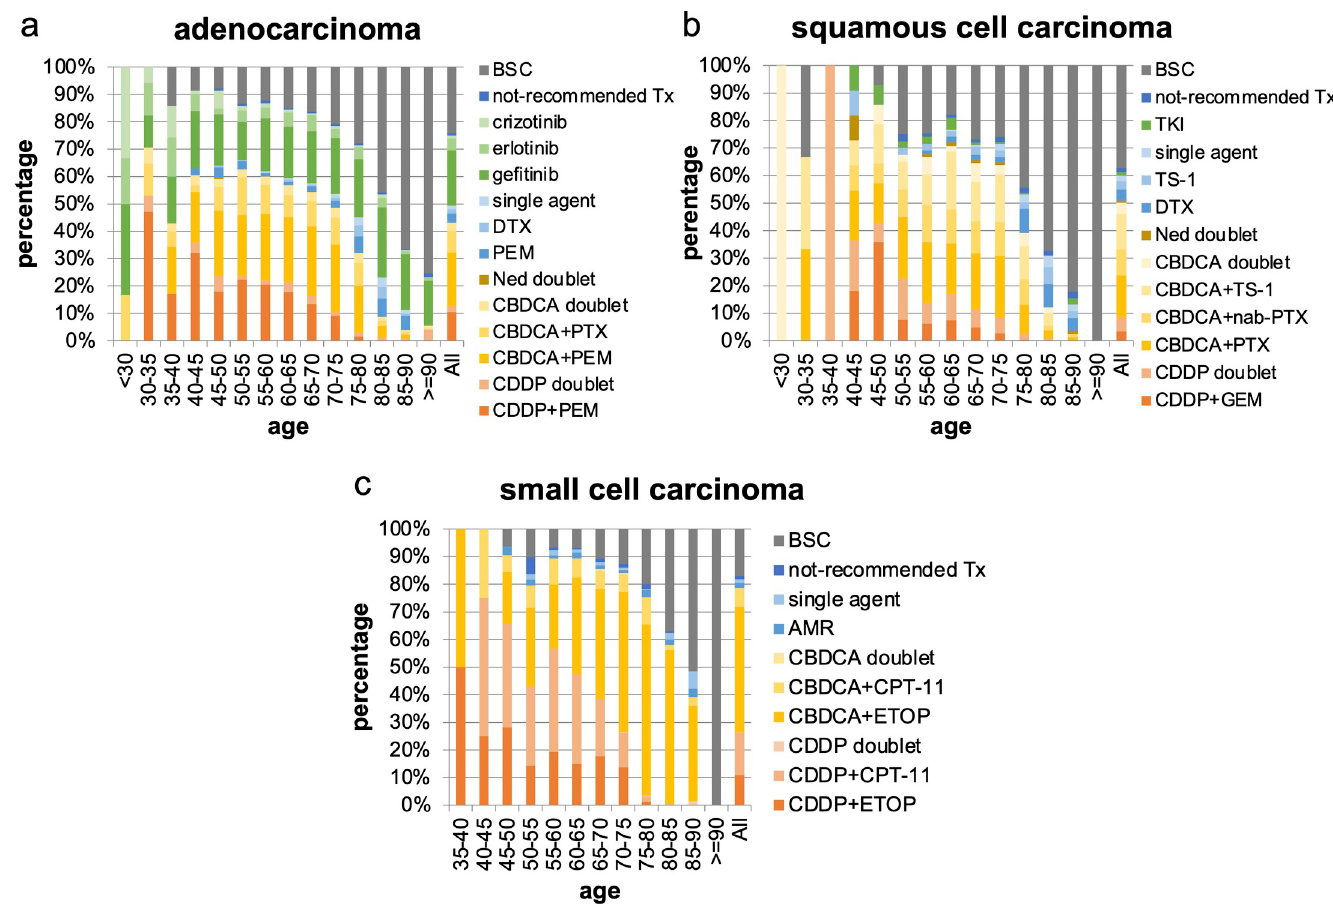
Fig 4. First-line treatment regimens by histology. (a) adenocarcinoma, (b) squamous cell carcinoma, and (c) small cell carcinoma. CDDP, cisplatin; PEM, pemetrexed; CBDCA, carboplatin; PTX, paclitaxel; Ned, nedaplatin; DTX, docetaxel; not-recommended Tx, not-recommended chemotherapy; BSC, best supportive care; GEM, gemcitabine; nab-PTX, nab-paclitaxel; ETOP, etoposide; CPT-11, irinotecan; AMR, amrubicin.